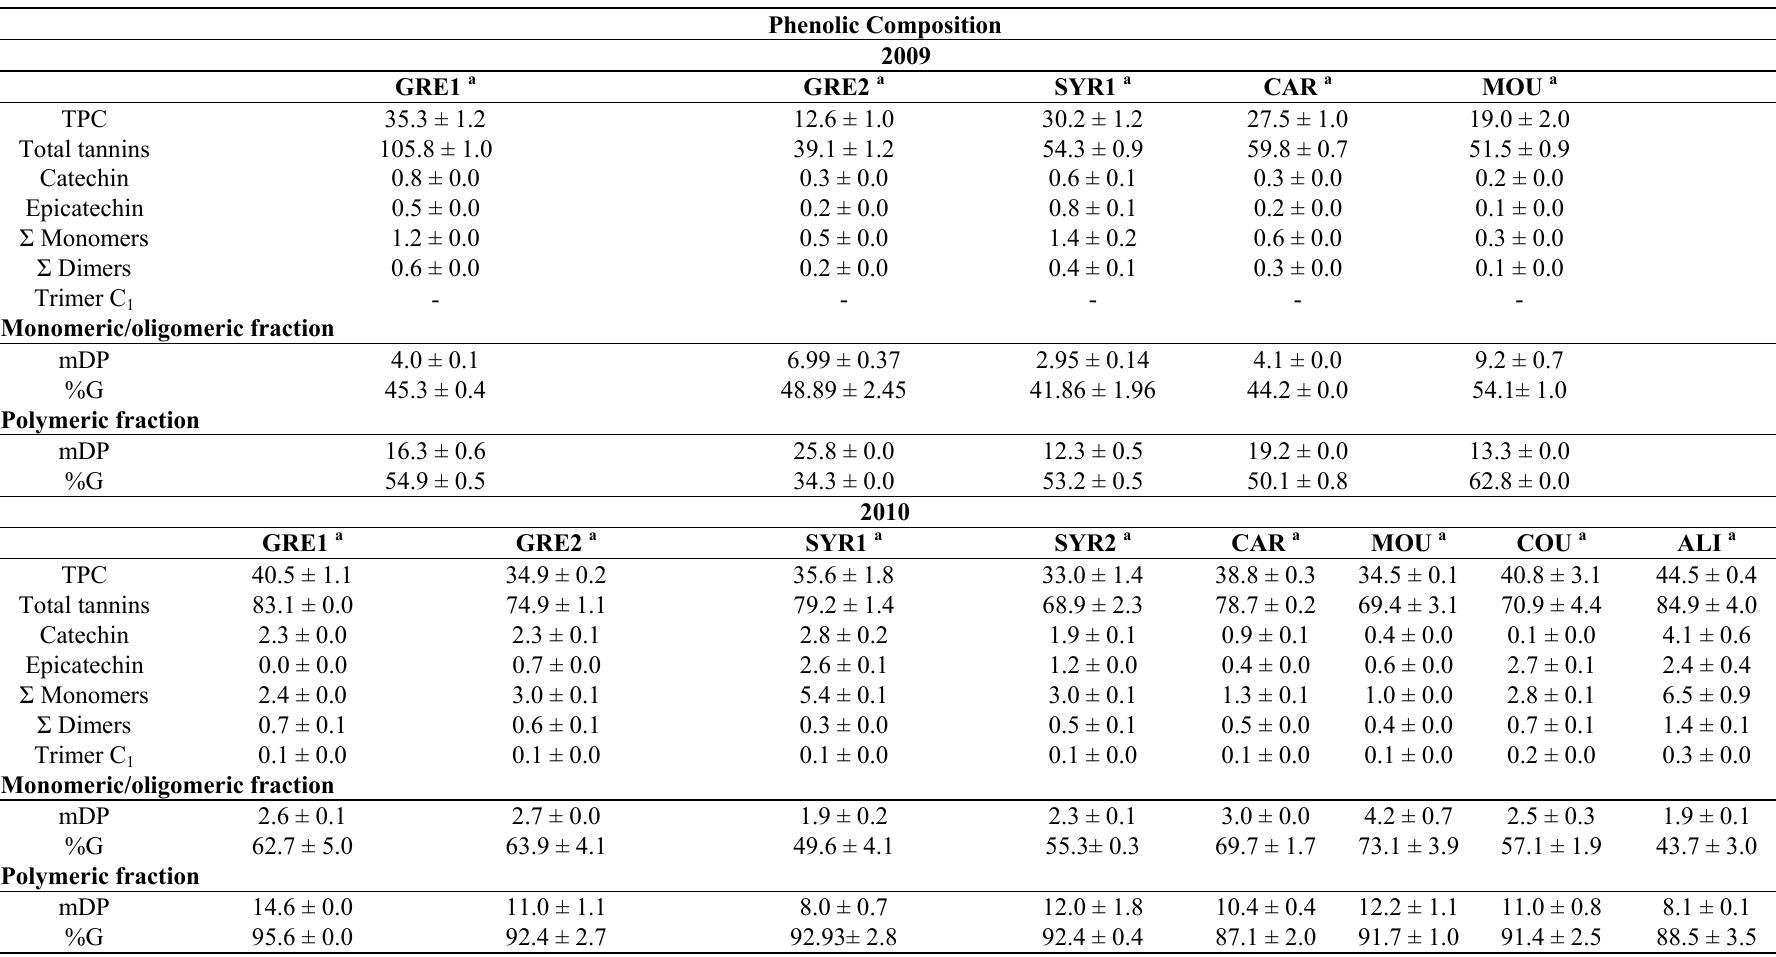
Table 2. Phenolic composition of grape pomace seeds in 2009 and